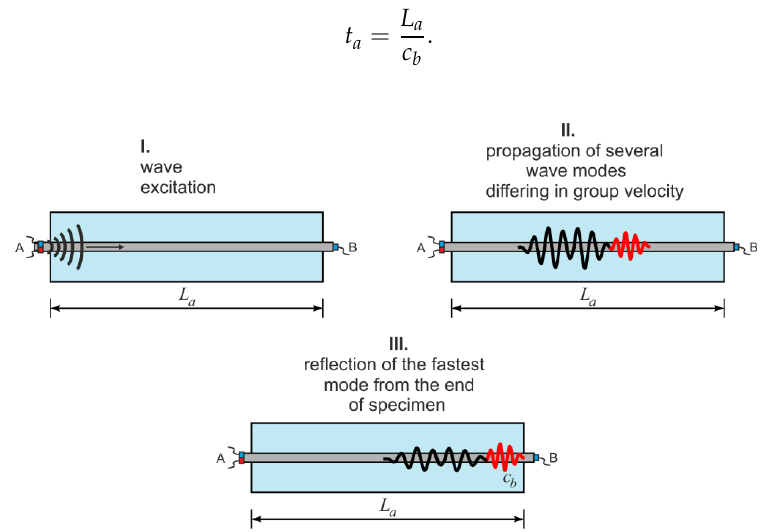
Figure 2. Multimode propagation in an undamaged RC beam.